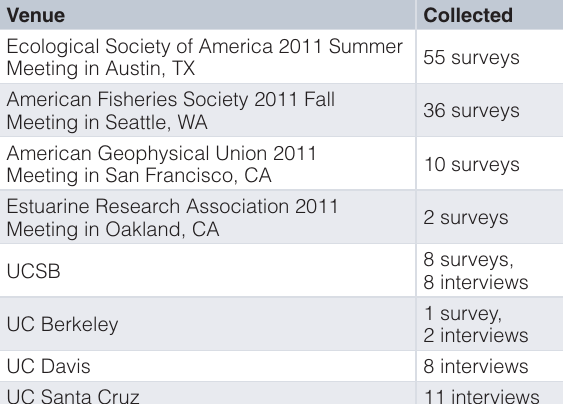
Table 1. Locations and events where survey and/or interview data were collected on requirements.